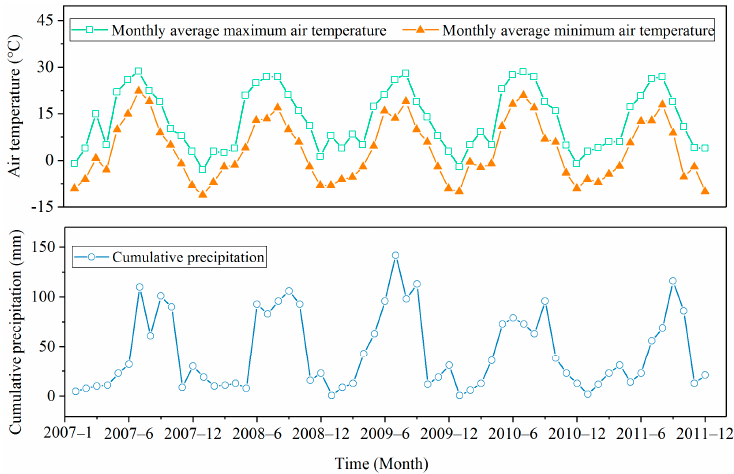
Figure 3. Monthly average air temperature and precipitation in